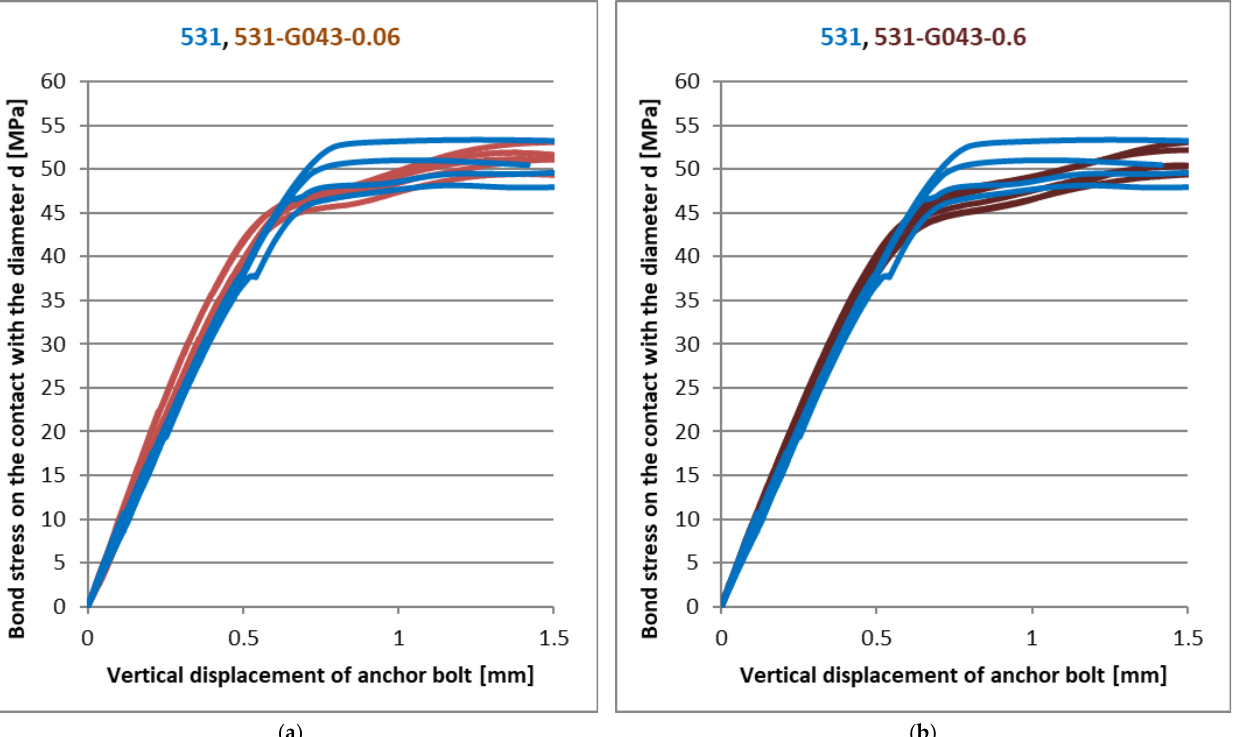
Figure 13. The effect of the graphene oxide GO43 on CHS Epoxy 531 ( a ) 0.06 phr; ( b ) 0.6 phr.